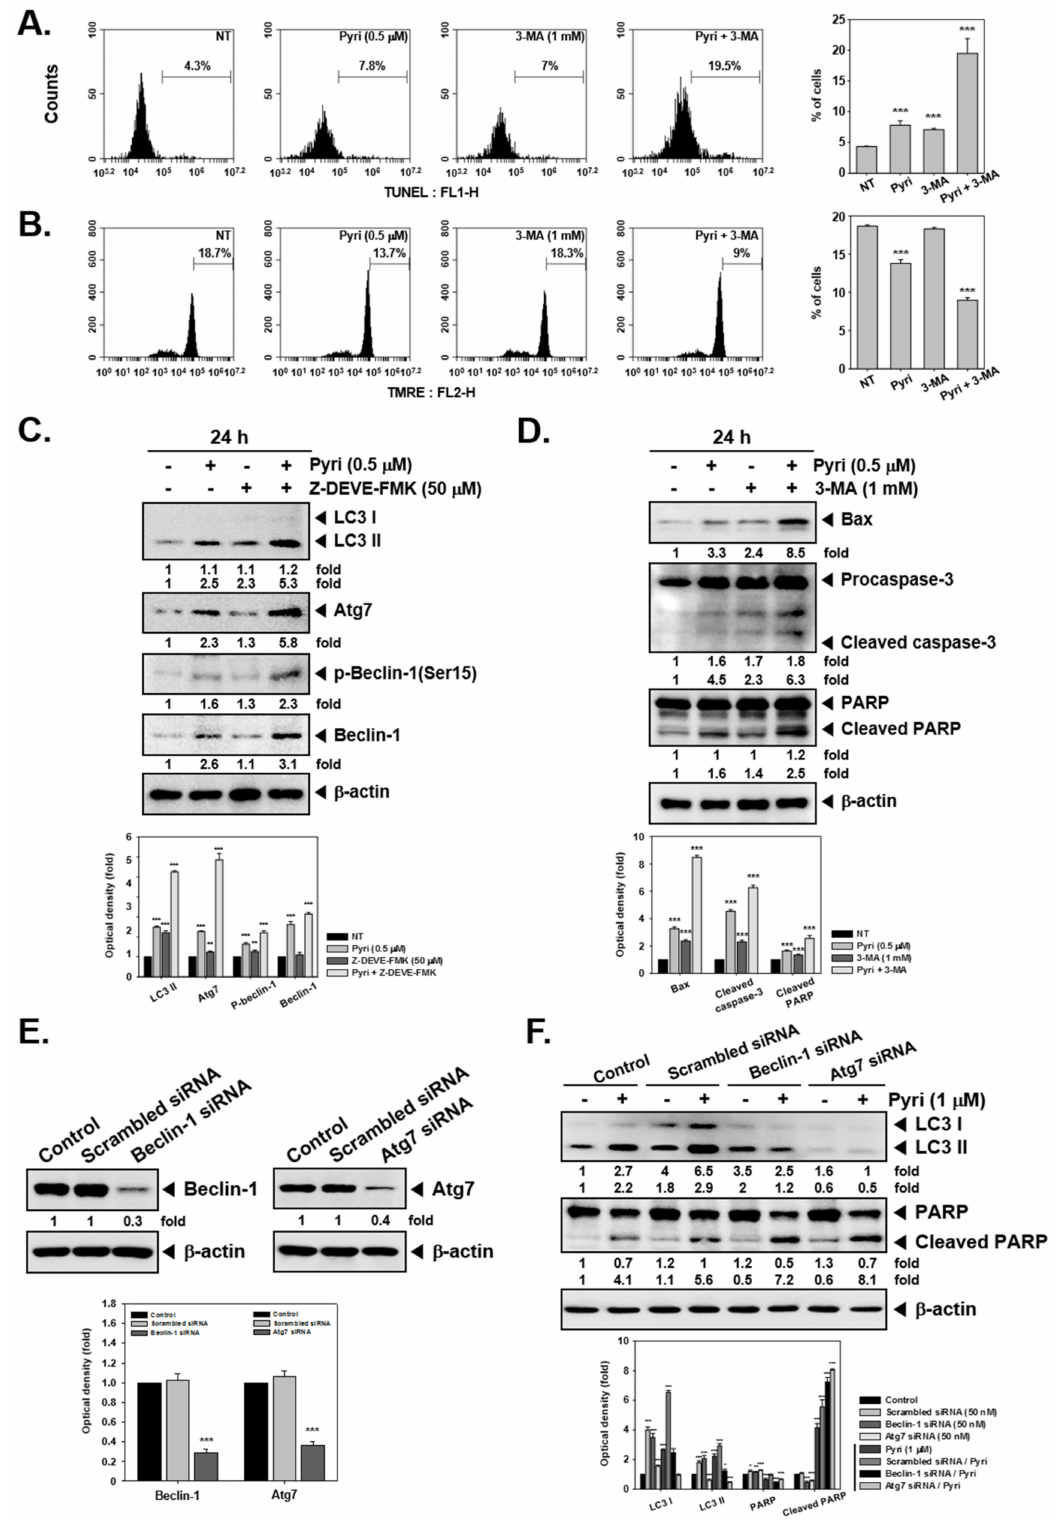
Figure 4. Inhibition of autophagy can sensitize the tumor cells to Pyri-induced apoptotic cell death. ( A , B ) KBM5 cells (1 × 10 6 cells/well) were pretreated with 1 mM concentrations of 3-MA for 30 min, and then exposed to Pyri (0.5 µ M) for 24 h. Then, the cells were fixed and incubated using TUNEL reaction solution or TMRE and then analyzed by a flow cytometry. ( C , D ) KBM5 cells (1 × 10 6 cells/well) were pretreated with 50 µ M of Z-DEVE-FMK and 1 mM concentrations of 3-MA for 30 min, then exposed to Pyri (0.5 µ M) for 24 h. Thereafter the western blot analysis was carried out. ( E , F )